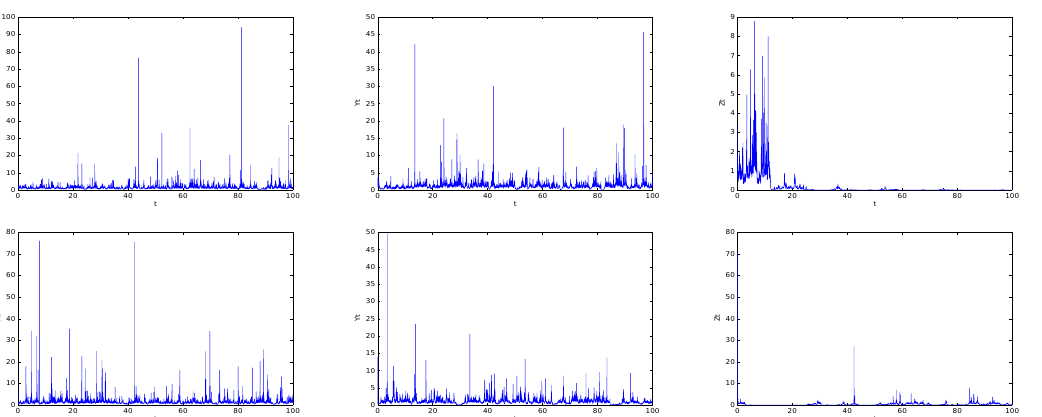
( t ) , y w ( t ) and z w ( t ) in Example 5.1 with w 0 = (3, 3, 3) . 0 0 0